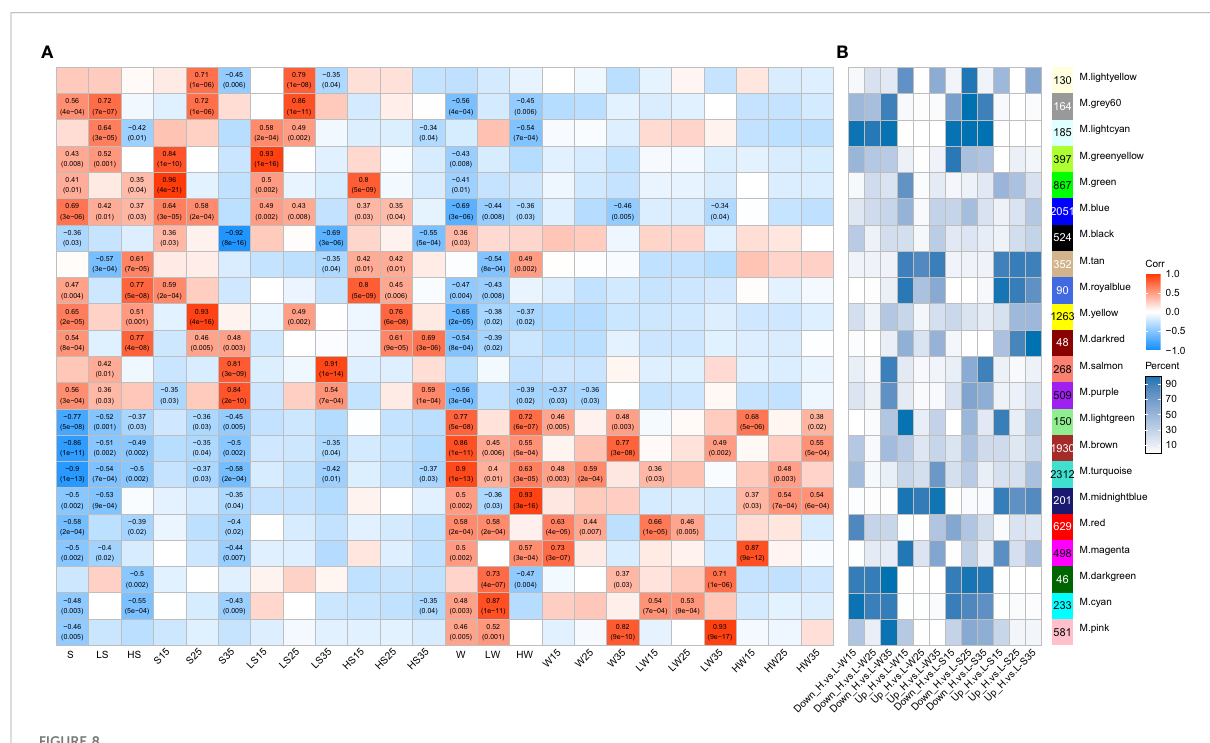
FIGURE 8 Correlations between module eigengenes and spatiotemporal traits of samples. (A) the module – trait associations. The numbers within the heatmap represent correlation coef fi cients and p values (in parentheses; red, positively correlated, blue, negatively correlated) for the module – trait associations. (B) distributions of each module in comparisons. This number is the number of genes from each module as a percentage of the total number of genes per module. Down_H.vs.L and Up_ H.vs.L, down- and up-regulated genes in L192 versus A260, respectively. S, seed. W, silique wall. 15, 25 and 35, 15, 25 and 35 days after fl owering,